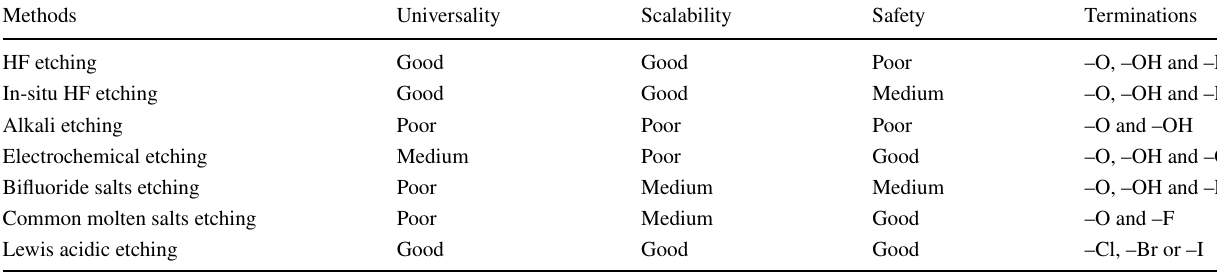
Table 1 Comparison of non-Lewis acidic etching techniques and Lewis acidic etching routes